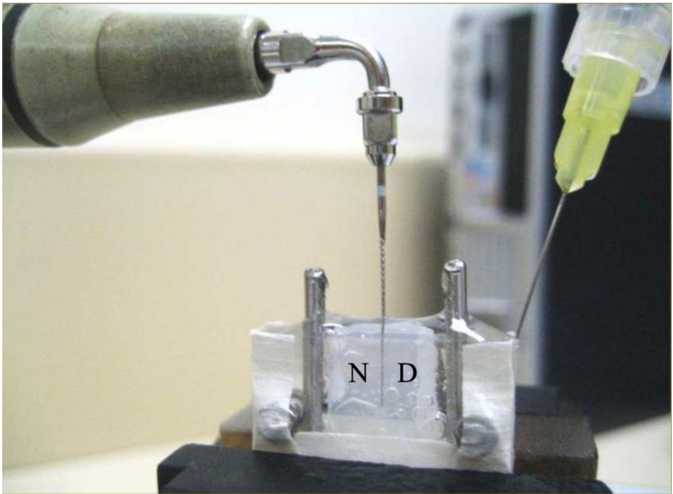
Figure 2. Experimental setup, with “N” = near-side to the ultrasonic handpiece, and “D” = distant side. Sterile saline solution was slowly injected into the simulated canal space to replenish any solution that was splashed out by the vibrating